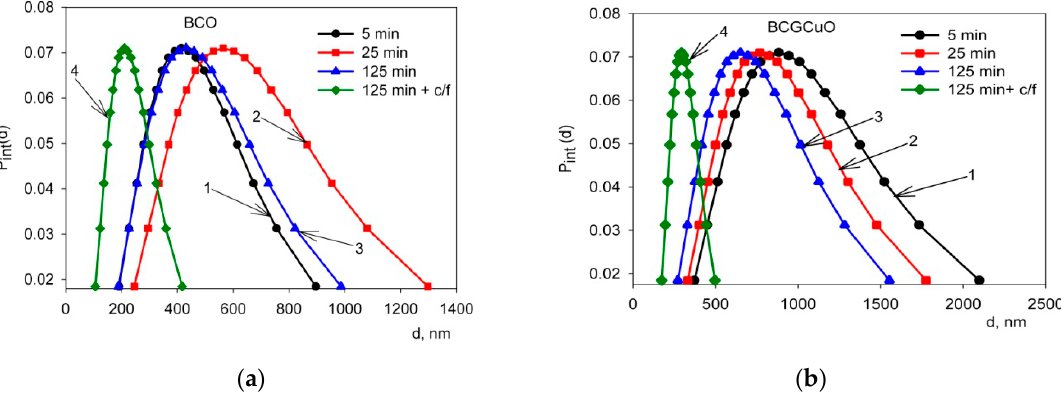
Figure 2. Unimodal distributions: ( a ) for the BCO suspension, UST 5 min (1), UST 25 min(2), UST 125 min (3), and ultrasonic treatment (UST) 125 min + centrifugation for 3 min at a speed of 1500 rpm (4); ( b ) for BCGCuO suspension, UST 5 min (1), UST 25 min(2), UST 125 min (3), and UST 125 min + centrifugation for 3 min at a speed of 1500 rpm (4), where Pint(d) is the probability density of the particle size distribution, d is the characteristic diameter of particles.